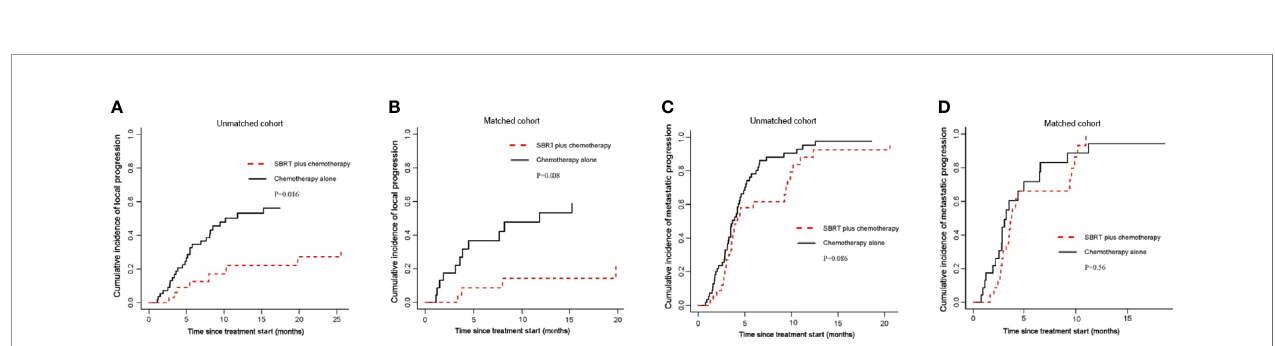
FIGURE 2 | Analyses of OS in matched population. (A) Forest plot of subgroup analyses of OS; (B) shows OS of the primary tumor location; (C) shows OS of performance status. SBRT, stereotactic body radiotherapy; PS, performance status.